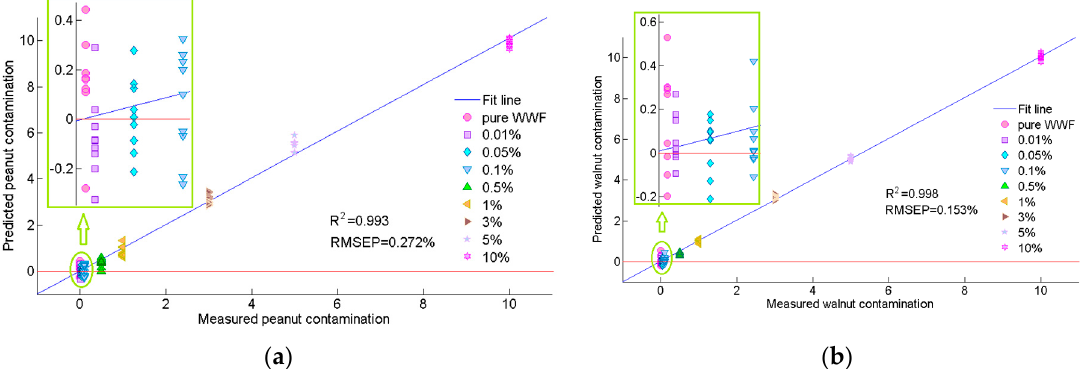
Figure 2. Performance of the best PLSR models for ( a ) peanut-contaminated flour and ( b ) walnut-contaminated flour applied on prediction sets based on full spectra (an enlarged view of the green circle part was shown in the green pane).